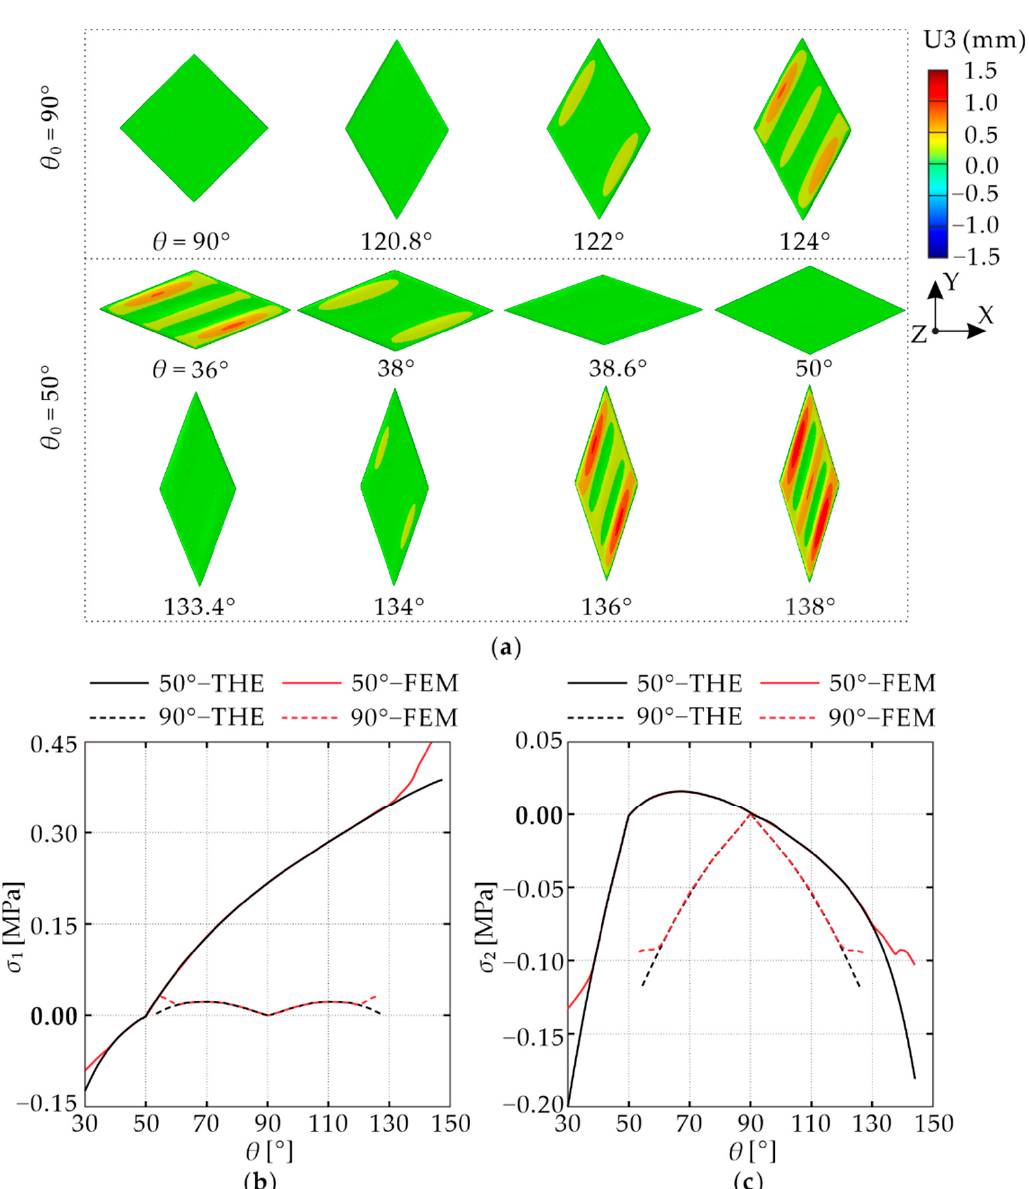
Figure 8. ( a ) Deformation process; ( b ) maximal principal stress versus morphing angle curves; ( c ) minimal principal stress versus morphing angle curves.